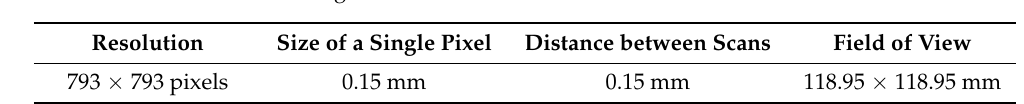
Table 5. Parameters of CT